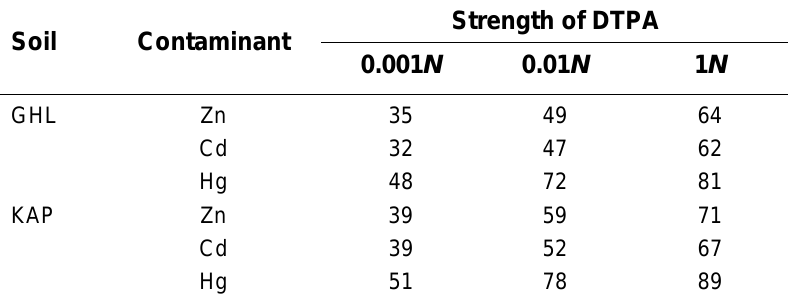
Removal of Zn, Cd, and Hg (%) from Contaminated-Spiked Soils Using DTPA